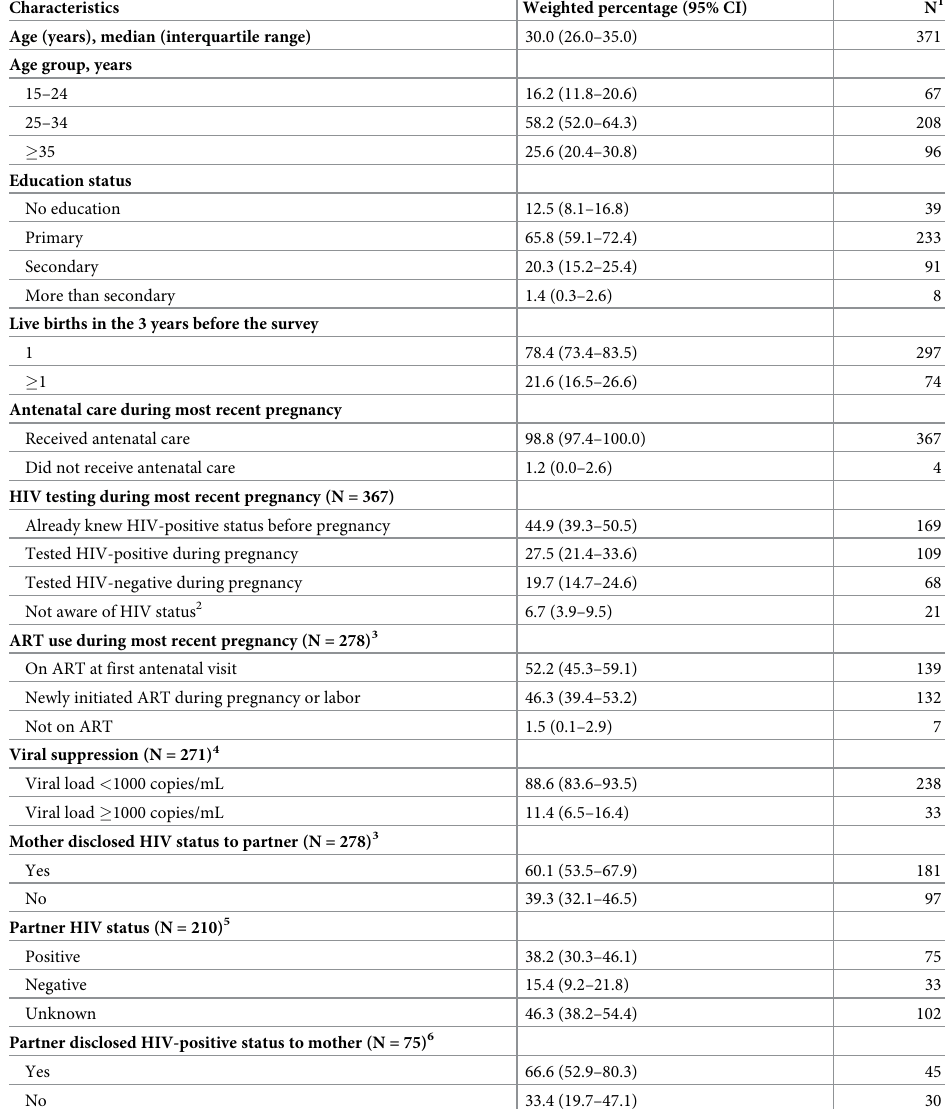
Table 1. Characteristics of HIV-positive women aged 15–64 years who had a live birth in the 3 years before the 2015–2016 Malawi Population-based HIV Impact Assessment (MPHIA) survey (N = 371).